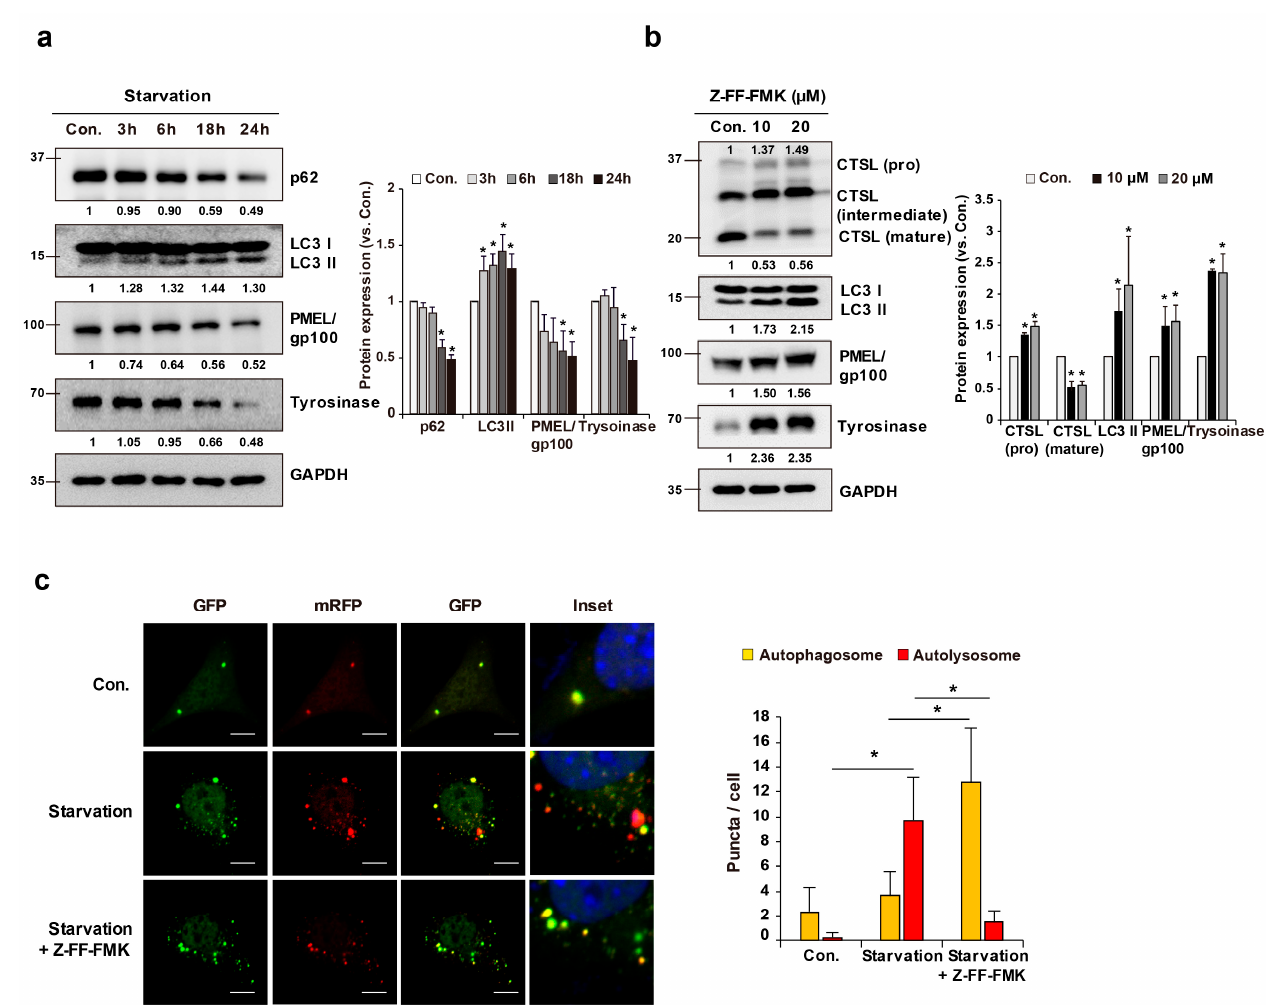
Figure 3. CTSL is associated with melanosome degradation through autophagy in melan-a cells. ( a ) Protein levels of p62, LC3, PMEL/gp100, and tyrosinase were examined under starvation conditions. ( b ) Melan-a cells were treated with Z-FF-FMK for 1 h and protein levels of CTSL, LC3, PMEL/gp100, and tyrosinase were evaluated. ( c ) After Z-FF-FMK pre-treatment and starvation for 8 h, tandem fluorescent-tagged LC3 (mRFP-GFP-LC3) was observed by confocal microscopy. Yellow (autophagosome) and red (autolysosome). Scale bar: 10 μ m. Results are expressed as mean ± S.D of more than three independent experiments. * p < 0.05. Student’s t -test.